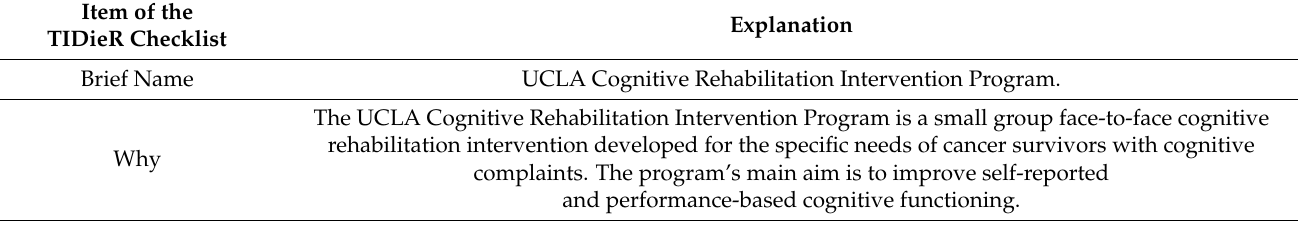
Table 1. UCLA Cognitive Rehabilitation Intervention